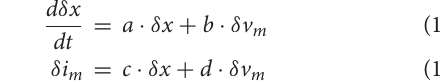
FIGURE 10 | Proof of evidence for the stabilization of the NDR operating point Q m simulation of the polynomial-based model. With reference to the circuit of Figure 8A , a resistor of resistance R s DC voltage V s of value 2.9V [see (A) ], and the memristor. As shown in (B–D) , the memristor state, voltage, and current in turn converge toward the DC values X 478, V m 0.937V, and I m 5.948mA as time goes to infinity. The DAE set initial condition x 0 , which may be chosen arbitrarily here, was fixed to = = =